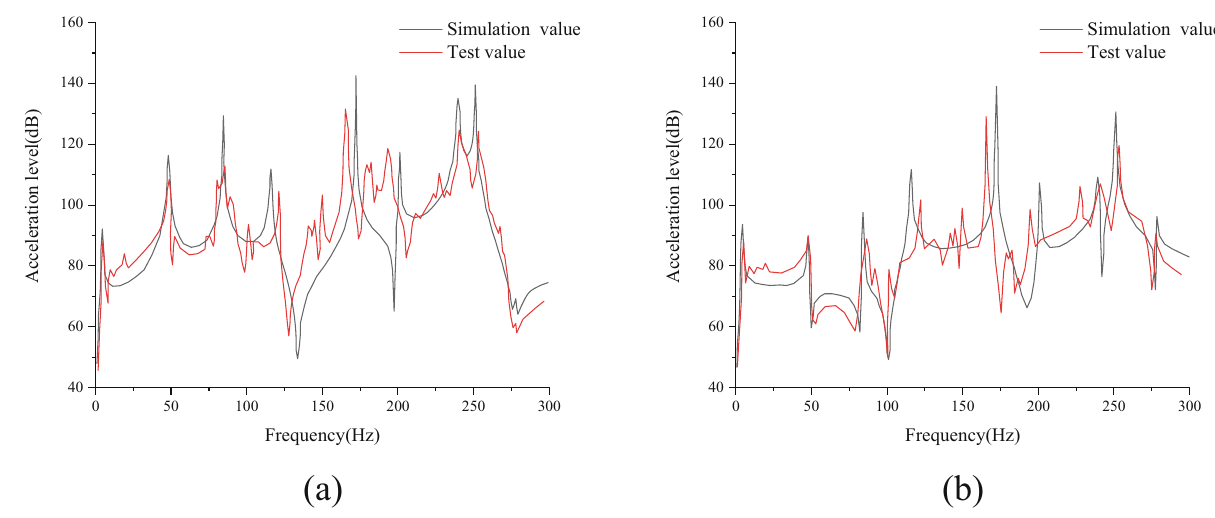
Figure 9: Vibration transmission test results of structure: ( a ) test point 1#; ( b ) test point